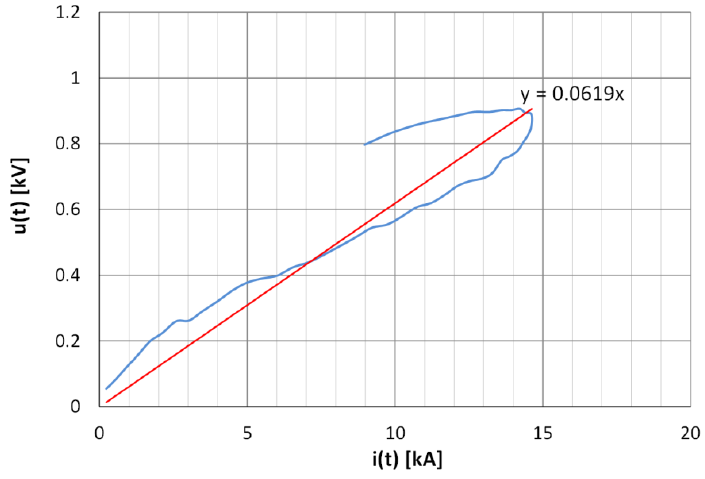
Figure 10. Voltage-current characteristic of the CFRP3 sample the for test with the fifth impulse (in blue) with added trend line (in red).